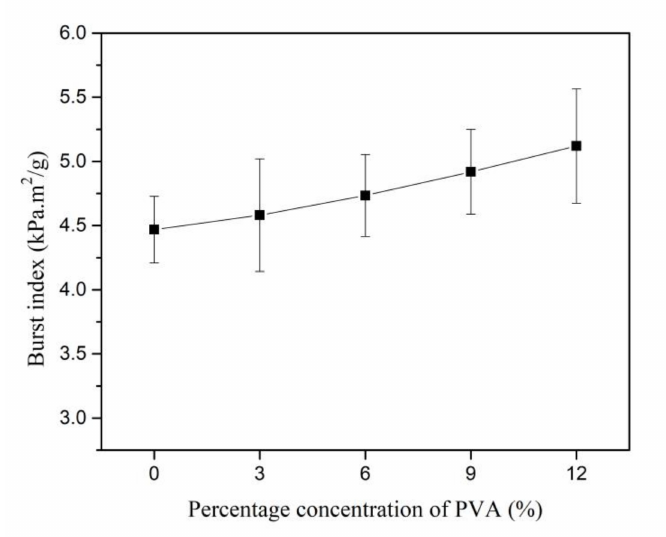
Figure 19. Burst index at di ff erent weight percentage concentration of